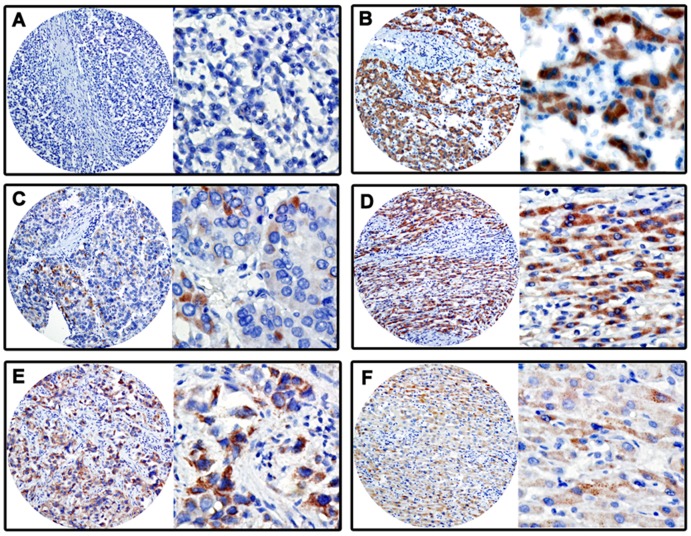
Protein expression patterns of SIRT3 in HCC tissues by IHC.The immunoreactivities were primarily observed in cytoplasm within tumor and normal liver cells. The micrographs showed negative (A), low (C), and high (E) expression of SIRT3 in HCC tissues. The relevant expressions of SIRT3 in corresponding adjacent normal liver tissues of cases in A, C and E were shown in B, D and F, respectively. (Left panel: magnification ×100; Right panel: magnification ×400.)